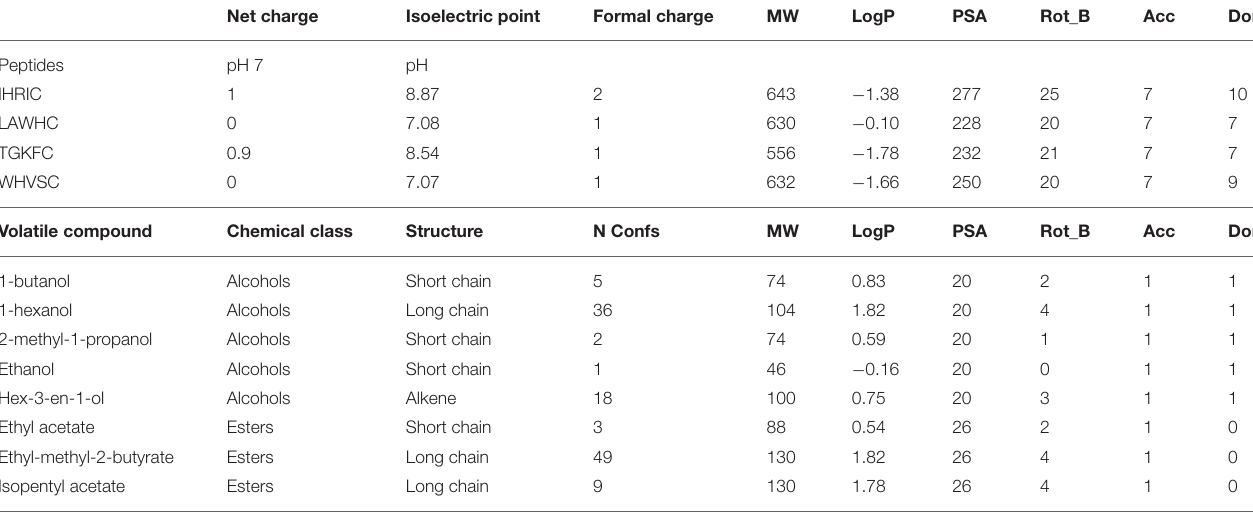
TABLE 1 | Structural and physicochemical properties of the four peptides and eight volatile compounds used in this work.